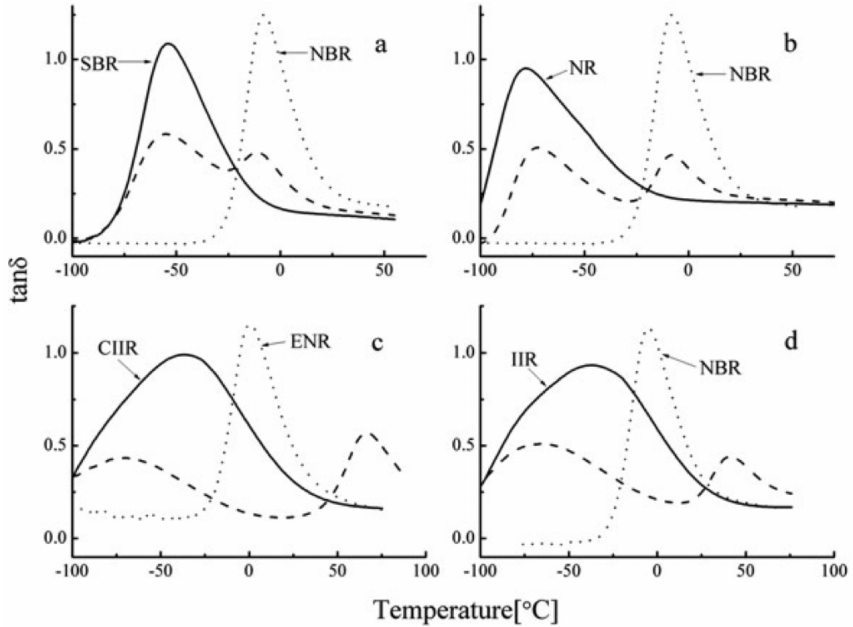
Figure 24. Temperature dependence of the damping loss factor (tan δ > 3) of other rubber blends such as ( a ) SBR/NBR; ( b ) NR/NBR; ( c ) CIIR/ENR and ( d ) IIR/NBR binary blends